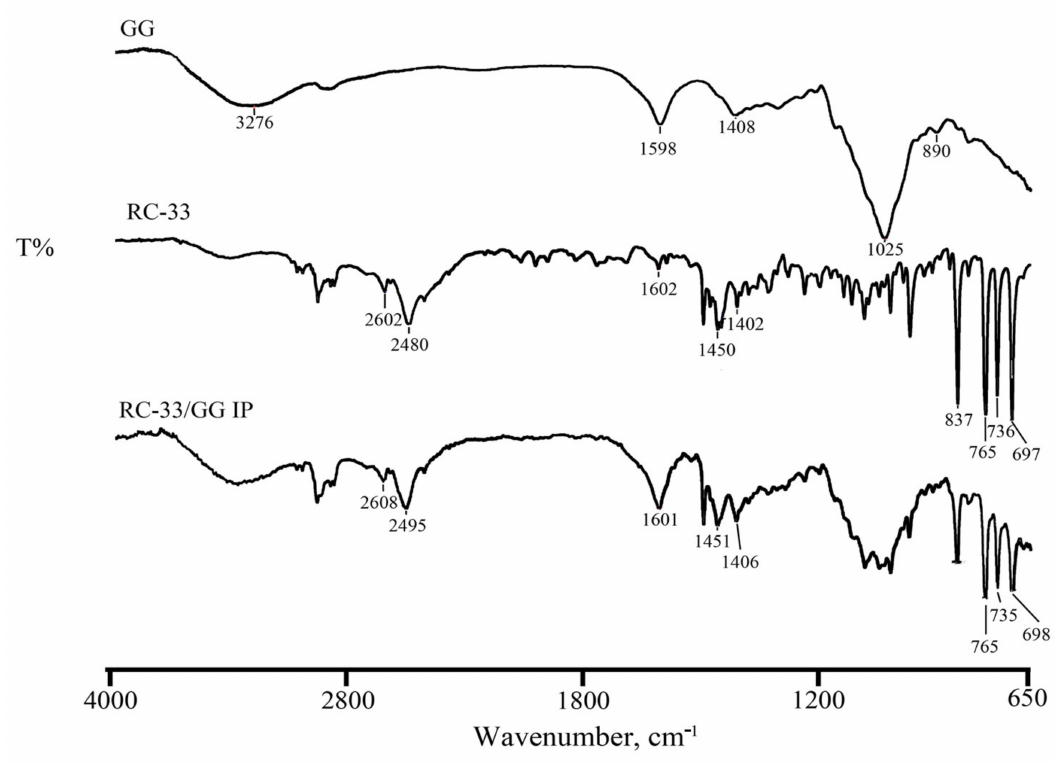
Figure 5. FT-IR spectra of GG, RC-33 and RC-33/GG IP. In FT-IR spectrum of pure GG, the bands at 1598 and 1408 cm − 1 are due to asymmetric and symmetric stretching of carboxylate group. The band at 2896 cm − 1 is due to the stretching vibrations of -CH 2 group, while those at 1148 and 1024 cm − 1 are due to ethereal and hydroxylic C-O stretching. Bending vibration of C-H appeared at 890 cm − 1 . The large band at around 3200–3400 cm − 1 is due to the presence of OH- group of glucopyranose ring. As for the drug, the characteristic vibration bands appear at 2602 and 2480 cm − 1 , at 1602, 1450 and 1402 cm − 1 in the region of C-C and C-N stretching in the ring, respectively. Moreover, three bands at 765, 736 and 697 cm − 1 in the region of C-H bending are observed. In the RC-33/GG IP spectrum, the shift of the RC-33 bands at 2602 and 2480 cm − 1 to higher wavenumbers can be detected, confirming the thermal